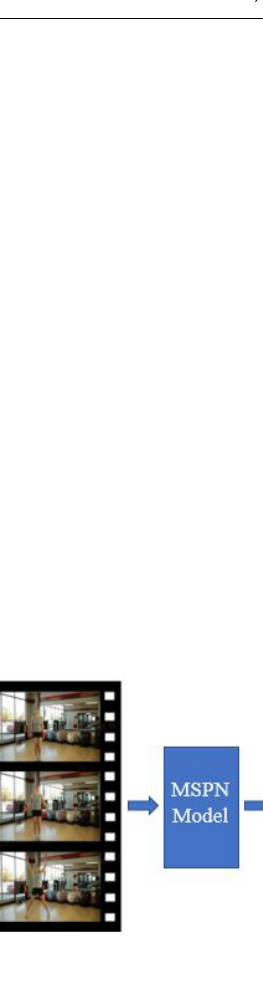
Figure 1. Illustration of the overall multitask system